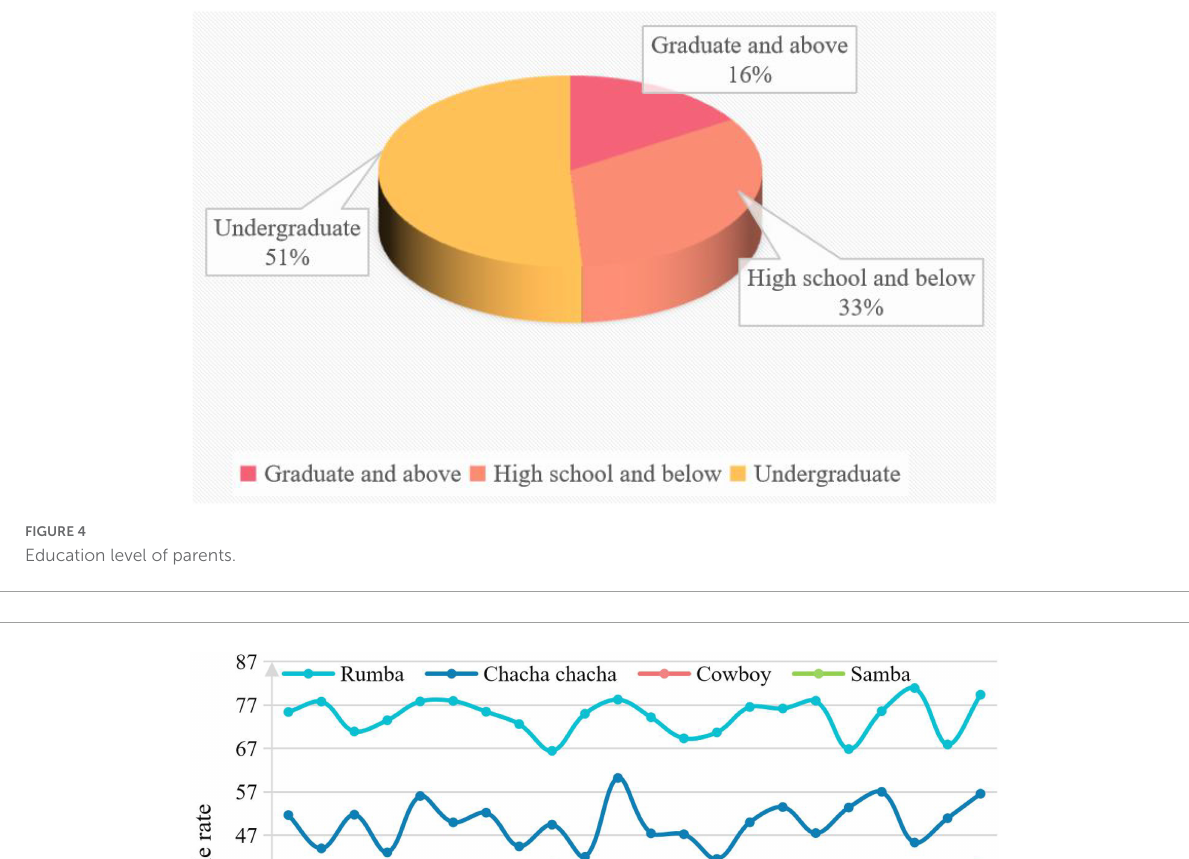
FIGURE5 Praise rate of students who have learned